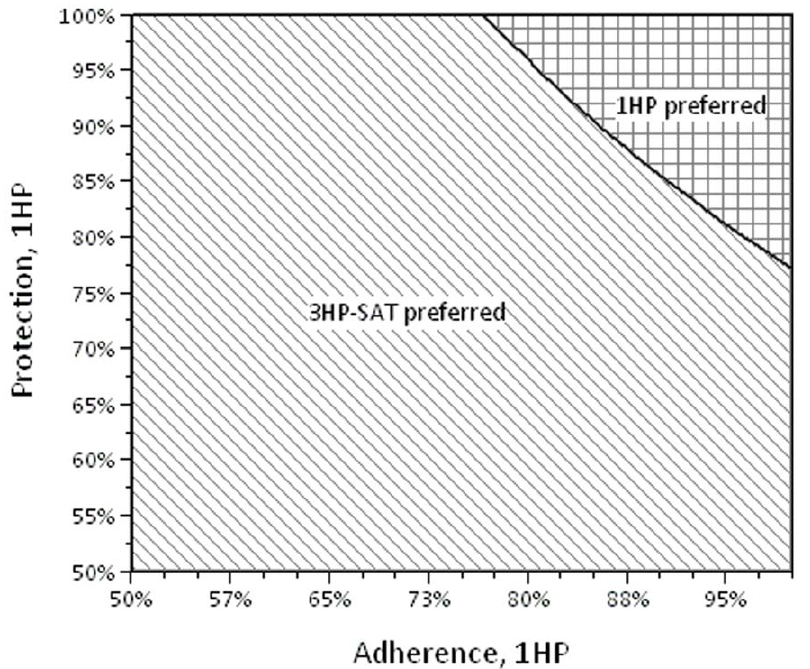
Figure 2. Two-way sensitivity analysis strategy graph comparing risk reduction and adherence for isoniazid/rifapentine daily for one month (1HP). The clear area shows combinations of adherence and risk reduction for 1HP that are high enough that 1HP is a cost-saving regimen. In the cross-hatched area, all combinations of adherence and risk reduction for 1HP are too low, so isoniazid/rifapentine monthly for 12 weeks self-administered (3HP-SAT) is preferred regimen.